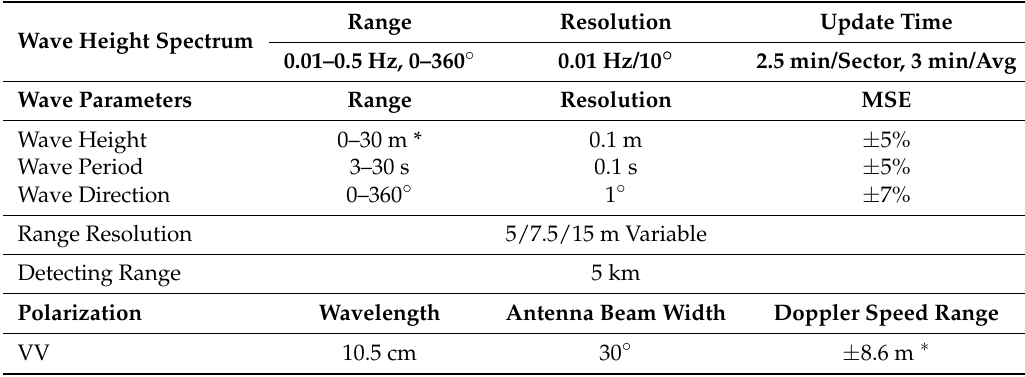
Table 1. Microwave Ocean Remote SEnsor (MORSE) radar system